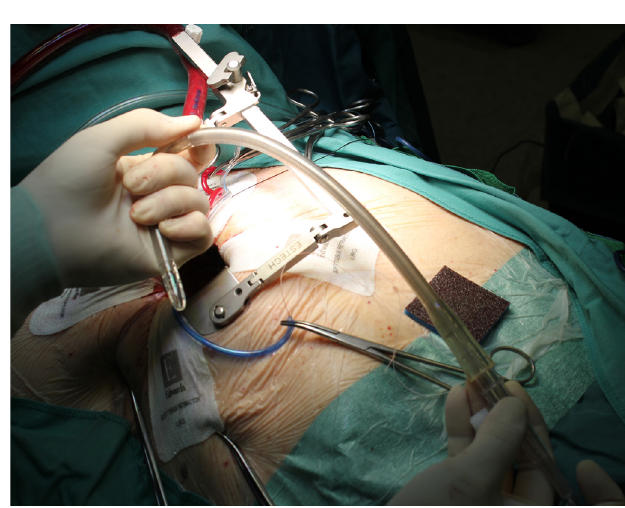
Fig. 5 - Bending the venous cannula with a metal spindle makes it easier to engage the inferior vena cava.